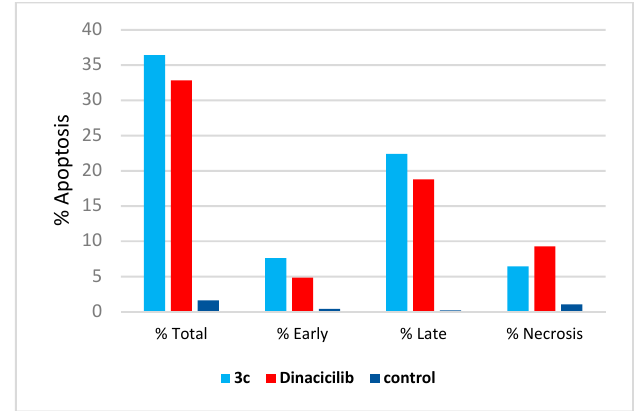
Figure 9. Percentage of apoptosis and necrosis for compound 3c on the SK-MEL-5 melanoma cell